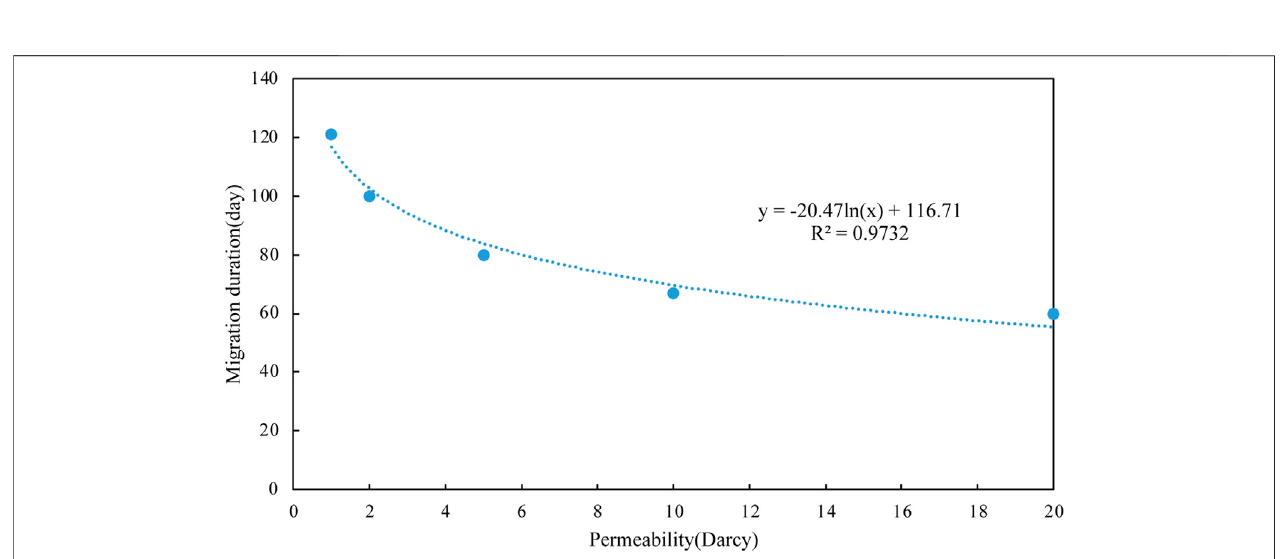
FIGURE 10 | Migration duration under different representative permeabilities of fracture zone.